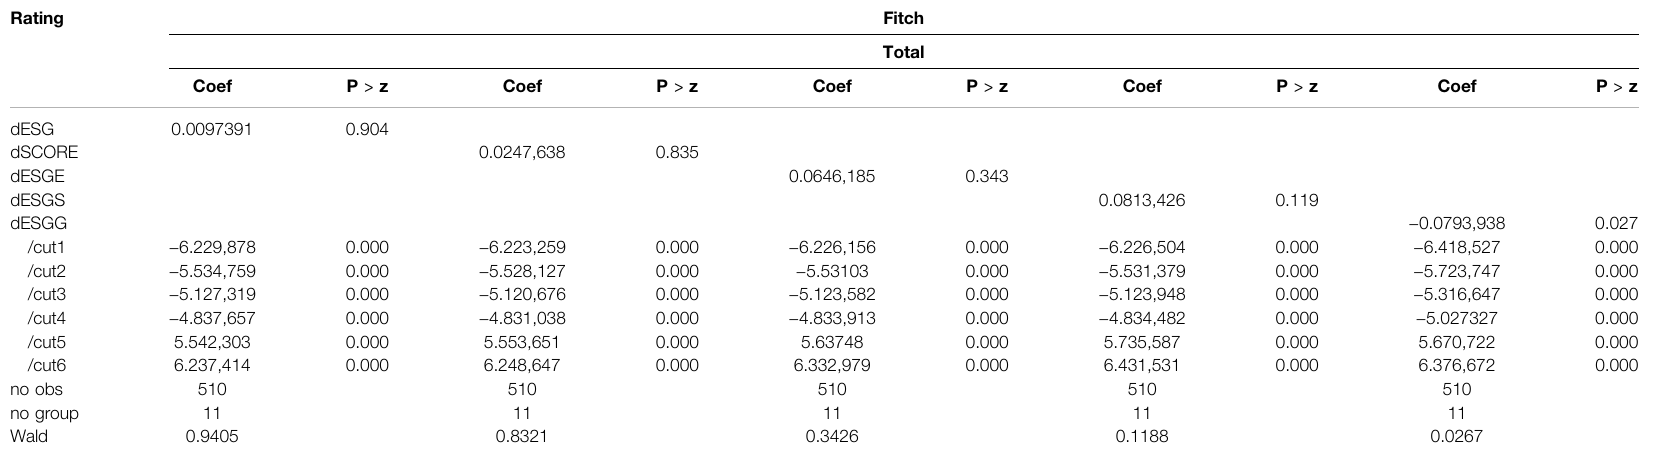
TABLE 9 | Impact of ESG factors on Fitch long-term issuer credit rating changes according to sector division. Rating